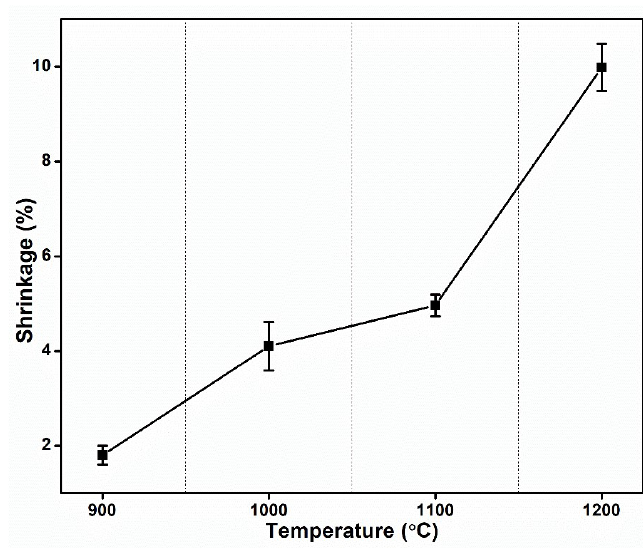
Figure 5. Variation of linear shrinkage with temperature.